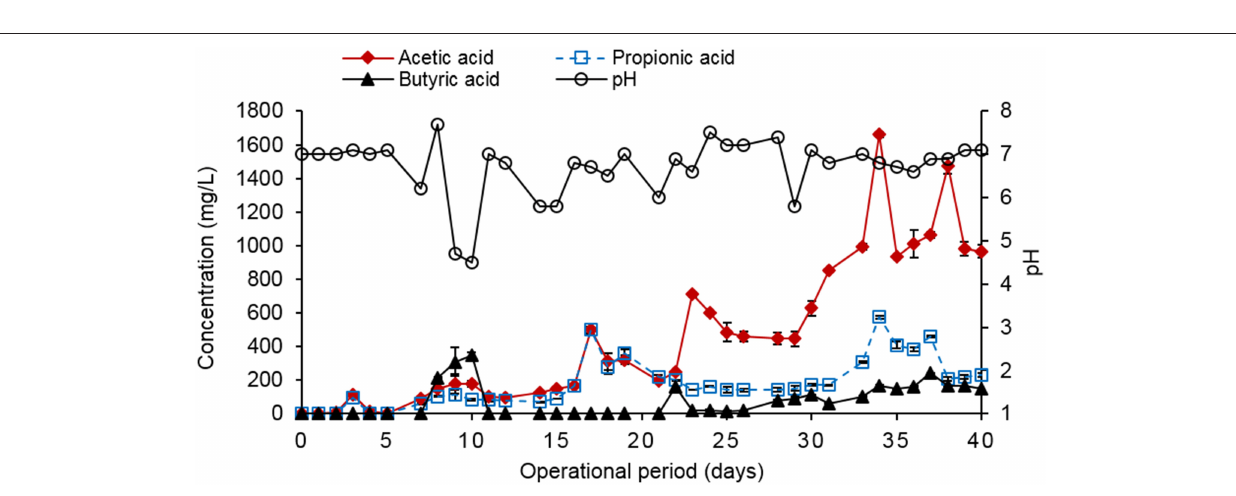
FIGURE 8 | VFA production in the control UASB